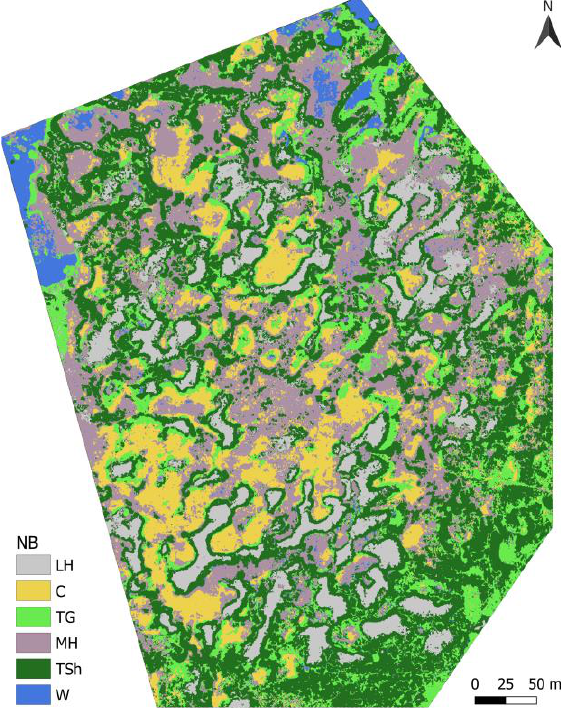
Figure 6. Land cover classification using the normal Bayes (NB) algorithm. Table 4. Percentage distribution of land cover classes computed by three machine-learning algorithms. Covered Area, Cover Type